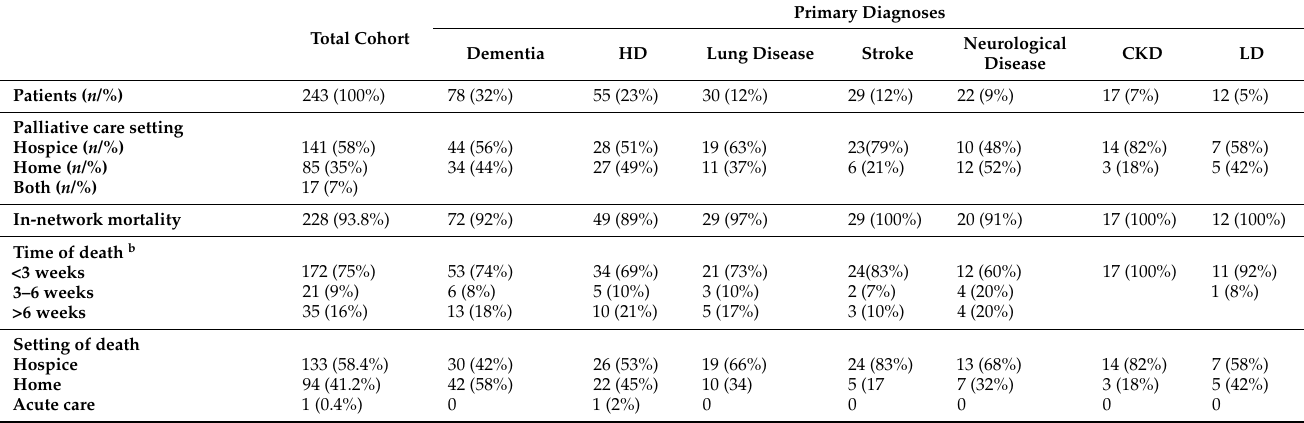
Table 2. Features and outcomes of palliative care a